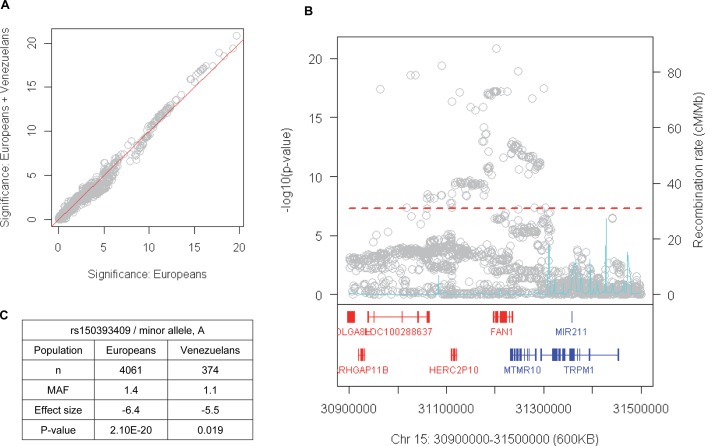
Improvement of chromosome 15 association signals by addition of Venezuelan HD data.(A) GWA analysis results for European HD subjects were combined with those of Venezuelans in order to determine whether or not addition of Venezuelan data improved modification association signals. Association signals in Europeans (X-axis) and that in Europeans + Venezuelans (Y-axis) are plotted. Open grey circles, which are above the red diagonal line, represent SNPs whose significance in association analysis was improved when European and Venezuelan data were combined. (B) A regional association plot was generated focusing on chromosome 15, revealing that rs150393409, which specifies an arginine to histidine missense alteration predicted to be deleterious to FAN1, is the most significant SNP in this region. (C) A summary table is shown focusing on the top SNP in European + Venezuelan HD analysis.